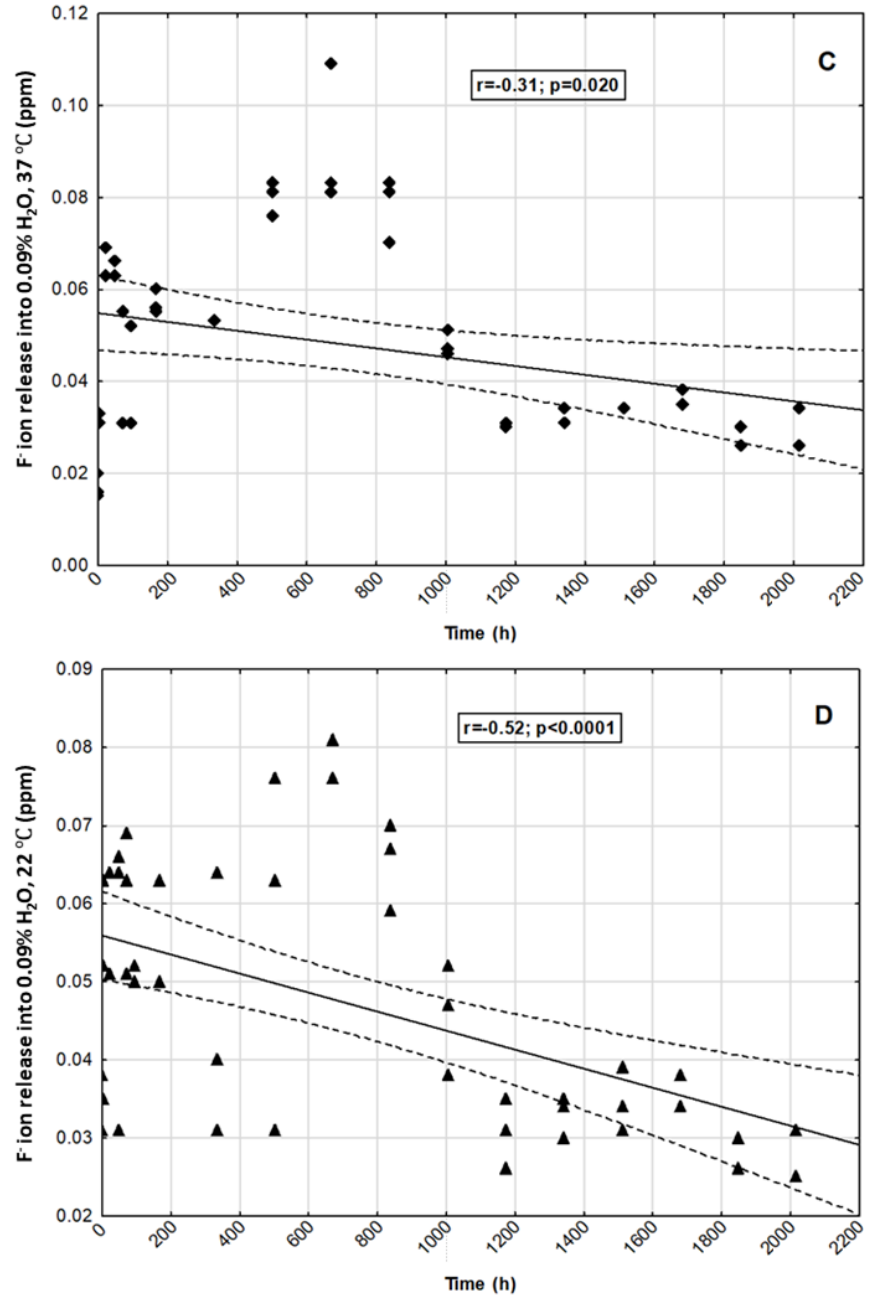
Figure 5. Correlation between selected time points and fluoride ion release into: A -0.9% NaCl, 37 °C; B -0.9% NaCl, 22 °C; C -H 2 O, 37 °C; D -H 2 O, 22 °C.